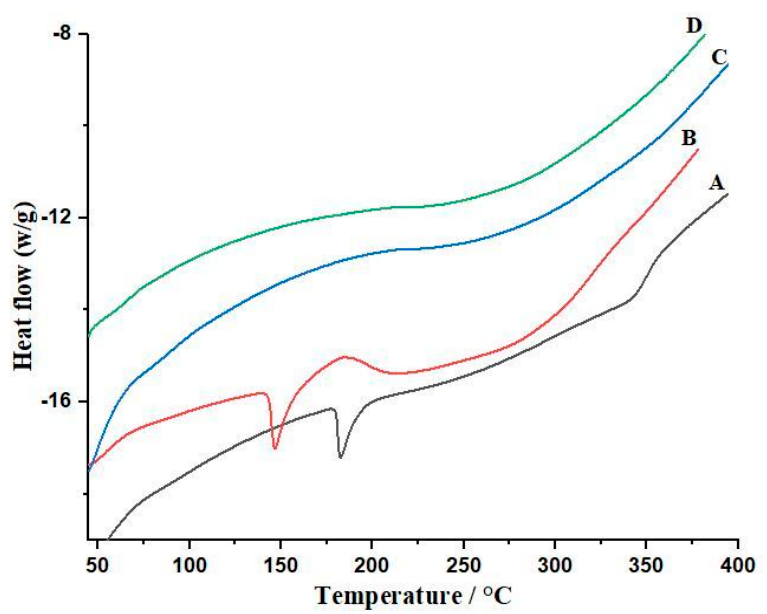
Figure 5. DSC of atorvastatin (A), ezetimibe (B), HPMC K-100 (C) and formulation F2 (D) .